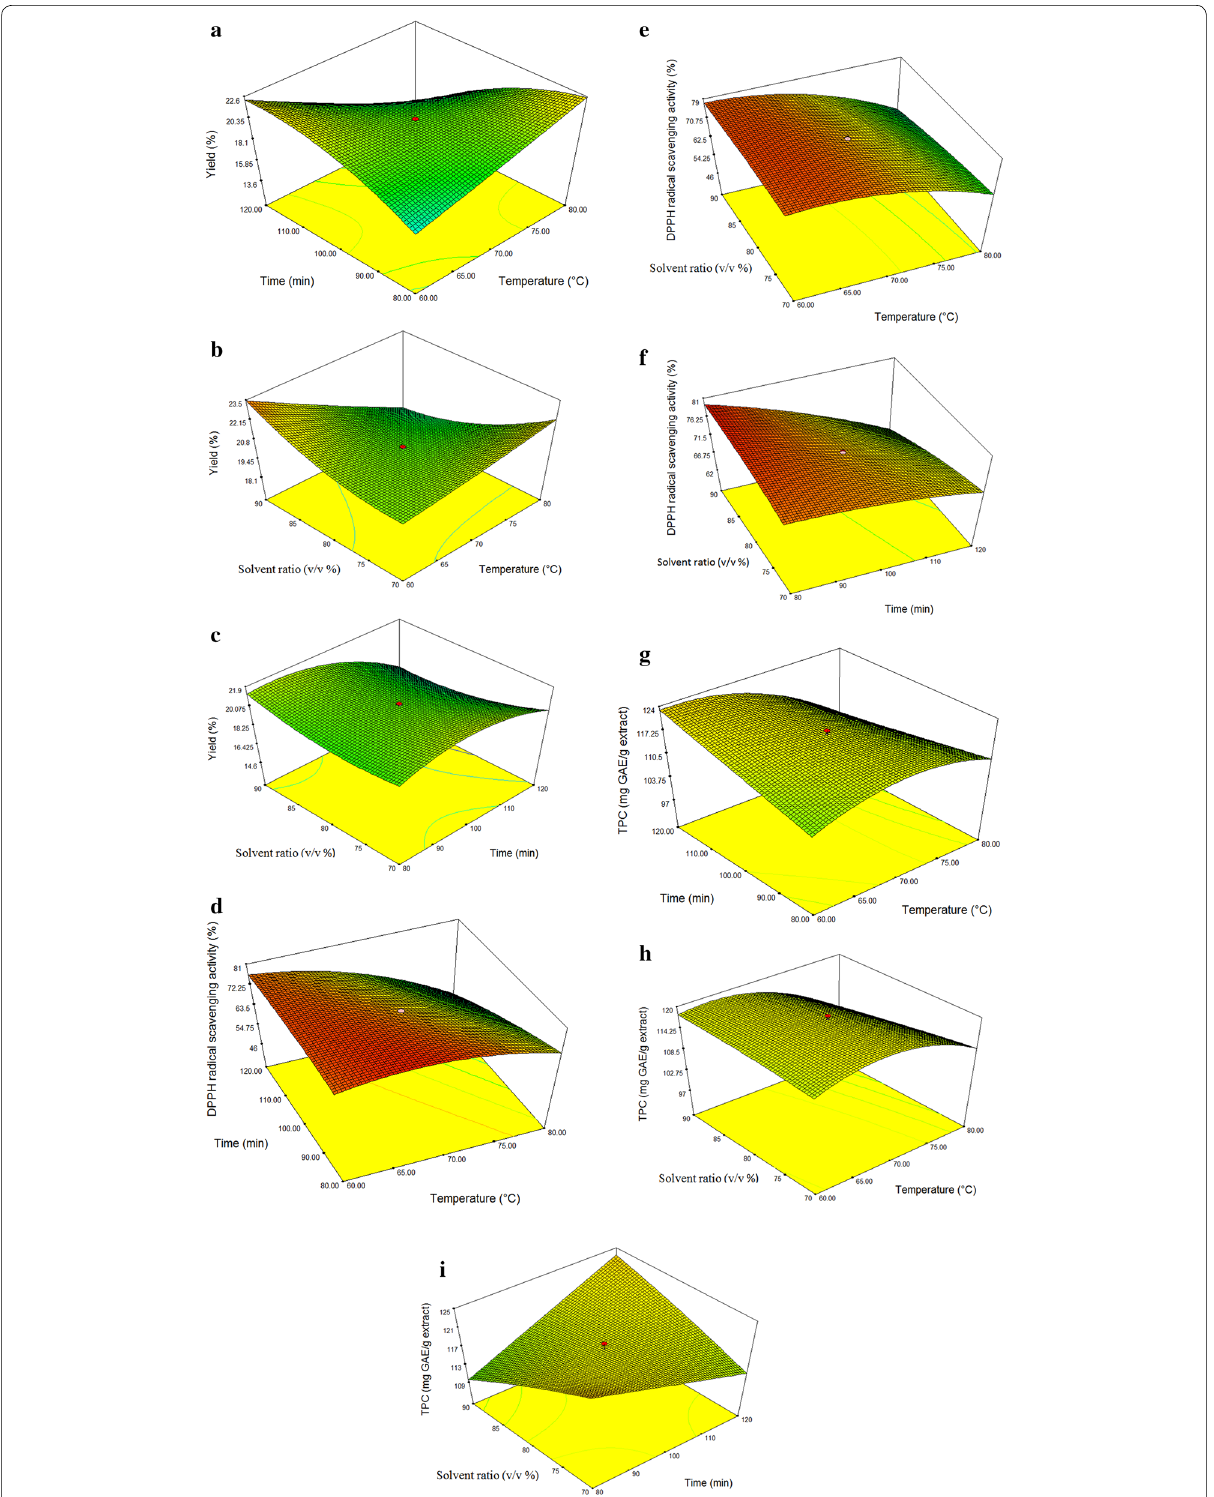
Fig. 2 Response surface plots; a – c the interaction effect of extraction yield as a function of extraction temperature, extraction time and solvent ratio, d – f the interaction effect of DPPH radical scavenging activity as a function of extraction temperature, extraction time and solvent ratio and g – i the interaction effect of TPC as a function of extraction temperature, extraction time and solvent